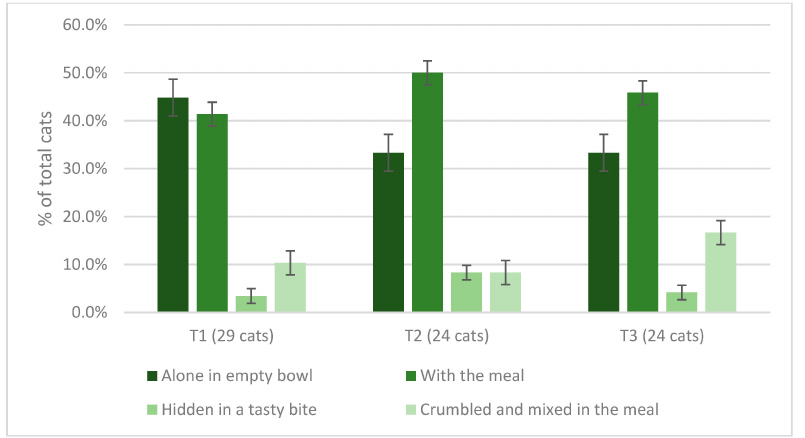
Figure 4. Method of offering of the increasing amounts of Spirulina offered to cats at T1, T2, and T3 of this study.